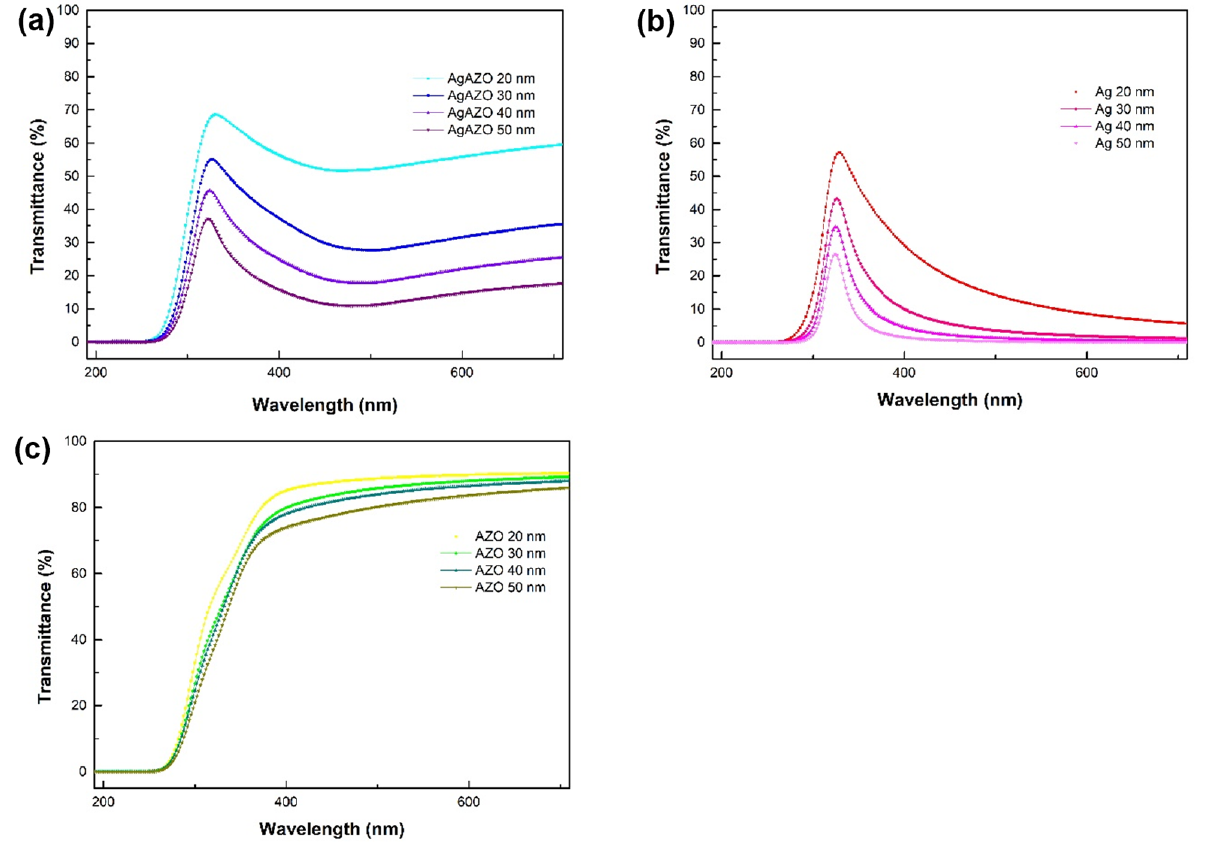
7 of 18 Figure 3. AFM images of the Ag:AZO thin film as a function of thickness. ( a ) 20; ( b ) 30; ( c ) 40; ( d ) 50 nm. Figure 4 shows the transmittance of the fabricated thin films in the wavelength range of 190 to 800 nm using a spectrophotometer. AZO, a transparent electrode, exhibited a high transmittance in visible light and a transmittance of 89% at a thickness of 20 nm. However, Ag exhibited a peak transmittance of 57% in the 320 nm wavelength band, and